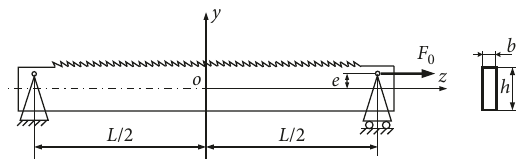
Figure 6: Model of the saw blade under an eccentric load. Table 1: Natural frequency f of the beam with the simply supported ends by Approach 1 and Approach